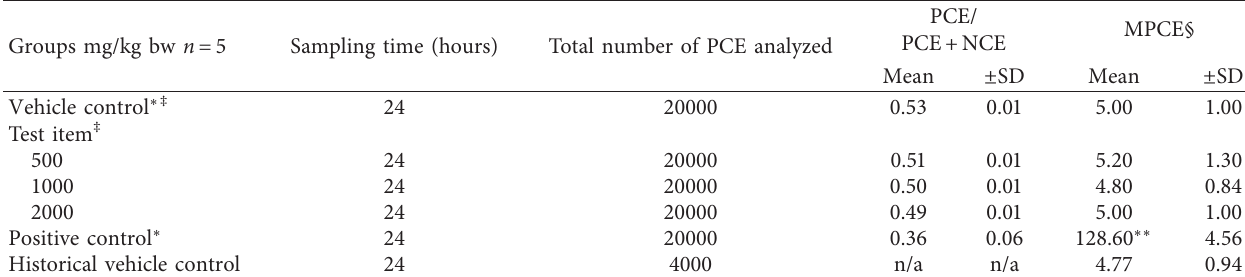
Table 4: Summary of mouse micronucleus test